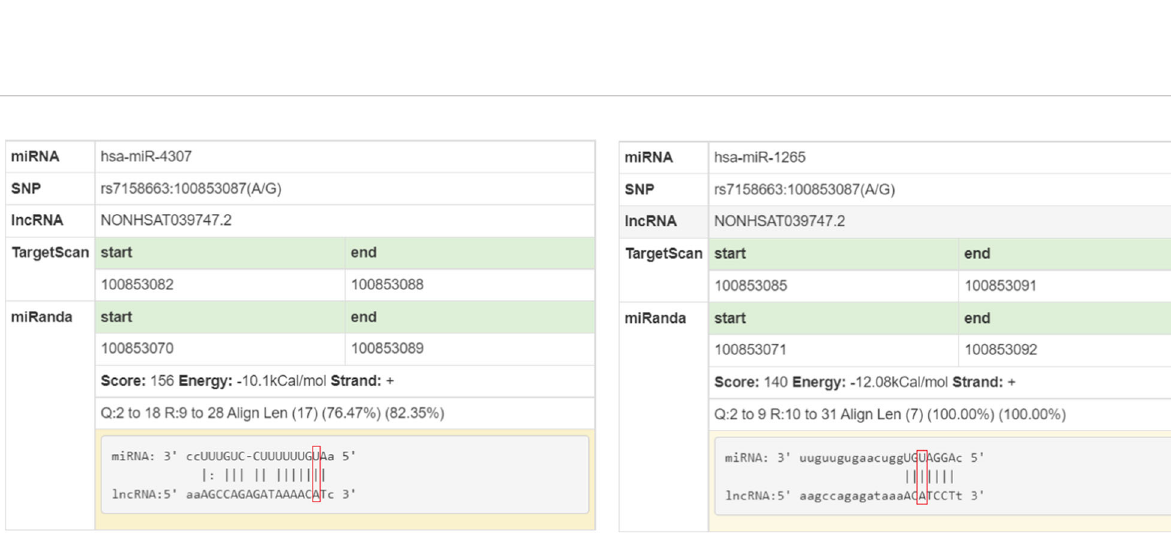
FIGURE 1 | Relationship between rs7158663 genotype and MEG3 expression in CRC tissues (A) and normal paracancerous tissues (B) . ***p < 0.001.